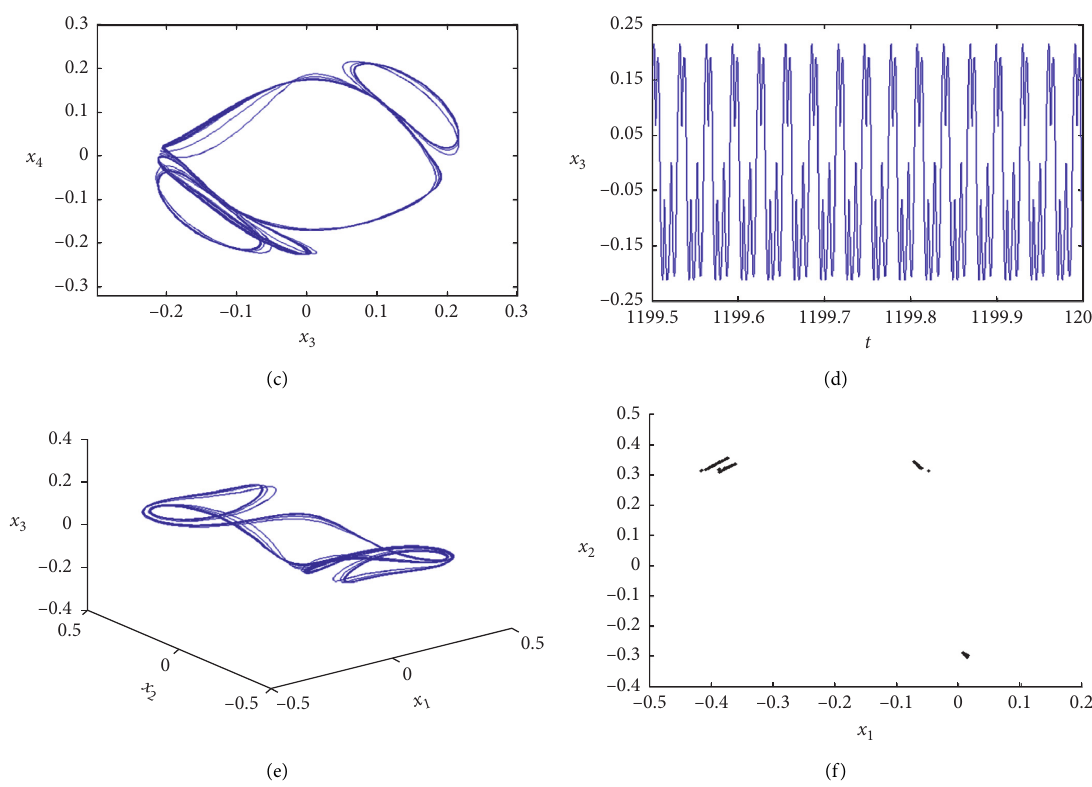
Figure 14: The multiperiodic oscillation of the cantilevered pipe conveying pulsating fluid is obtained when the external excitation is F � 2 . 9. (a) Phase portrait on plane ( x ( t, x ) , (e) three-dimensional phase portrait in space ( x 3